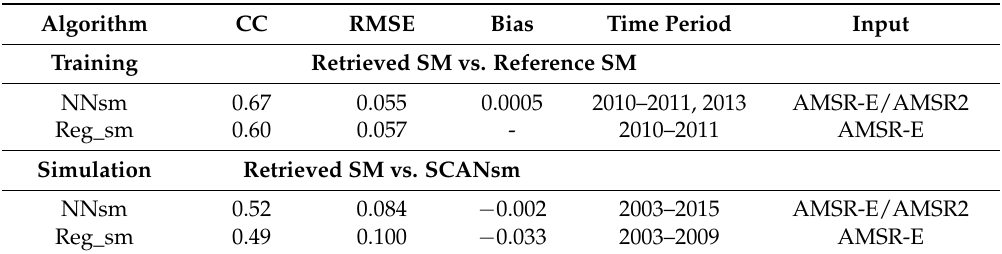
Table 4. Comparative results between retrieved SM and reference SM/in situ SCAN observations (selected 15 sites) in the training and simulation period. Only significant correlations ( p -value < 0.05) are